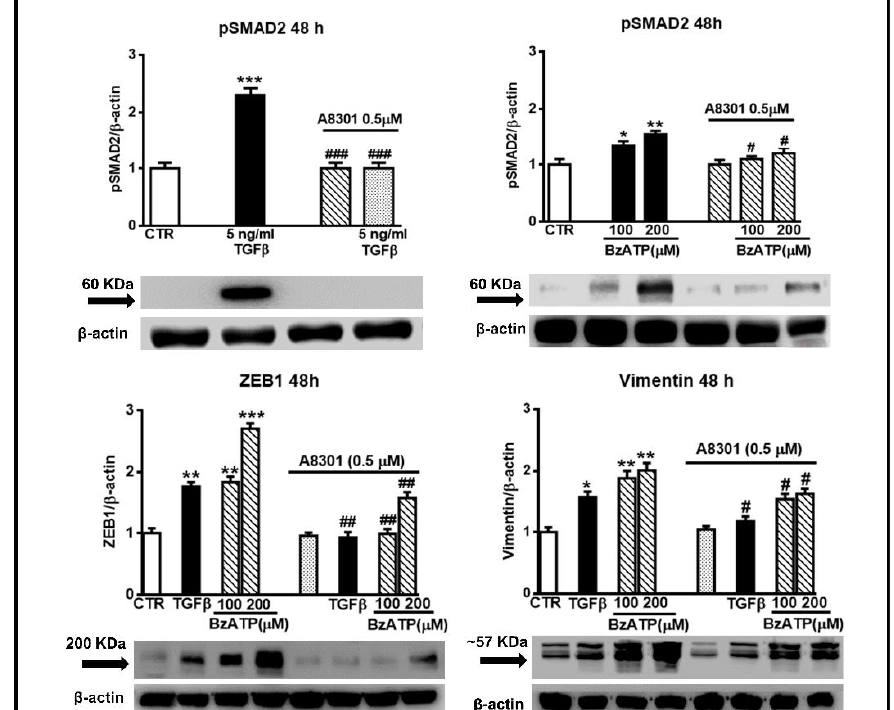
Figure 9. Increase in SMAD2 phosphorylation is involved in the effects promoted by either TGFβ or BzATP on EMT markers. GSCs were exposed to TGFβ1 or BzATP at the indicated concentrations. In some experiments, cells were pretreated with A8301, inhibitor of TGFβ type I receptors, which was added alone or 2 h prior to the other two drugs. After 48 h, cells were harvested and the protein levels of phosphorylated SMAD2 (pSMAD2) and some EMT markers were determined by western blot analysis. As for pSMAD2, different aliquo ts of proteins, derived from TGFβ or BzATP treated cells (60 or 80 μg, respectively), were used for the electrophoretic run, to make more evident the BzATP effect. Immunoblots were obtained by exposing membranes to the appropriate antibodies. Then, they were reprobed with an antibody against β actin and quantified by densitometric analysis, the values of which, normalized to β actin used as an internal control, are reported in the histograms, assuming the value of control / β -actin = 1. Immunobands in the figure are related to GSCs #2 and are representative of three independent experiments carried out for each cell type giving similar results. * p < 0.05, ** p < 0.01, *** p < 0.001: statistical significance vs. untreated GSCs assumed as control (CTR) (one-way ANOVA plus Dunnett’s test); # p < 0.05; ## p < 0.01; ### p < 0.001 vs. cells treated with TGF β 1 or